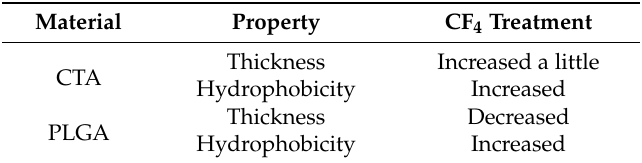
Table 1. Effects of the CF 4 treatment on CTA and PLGA